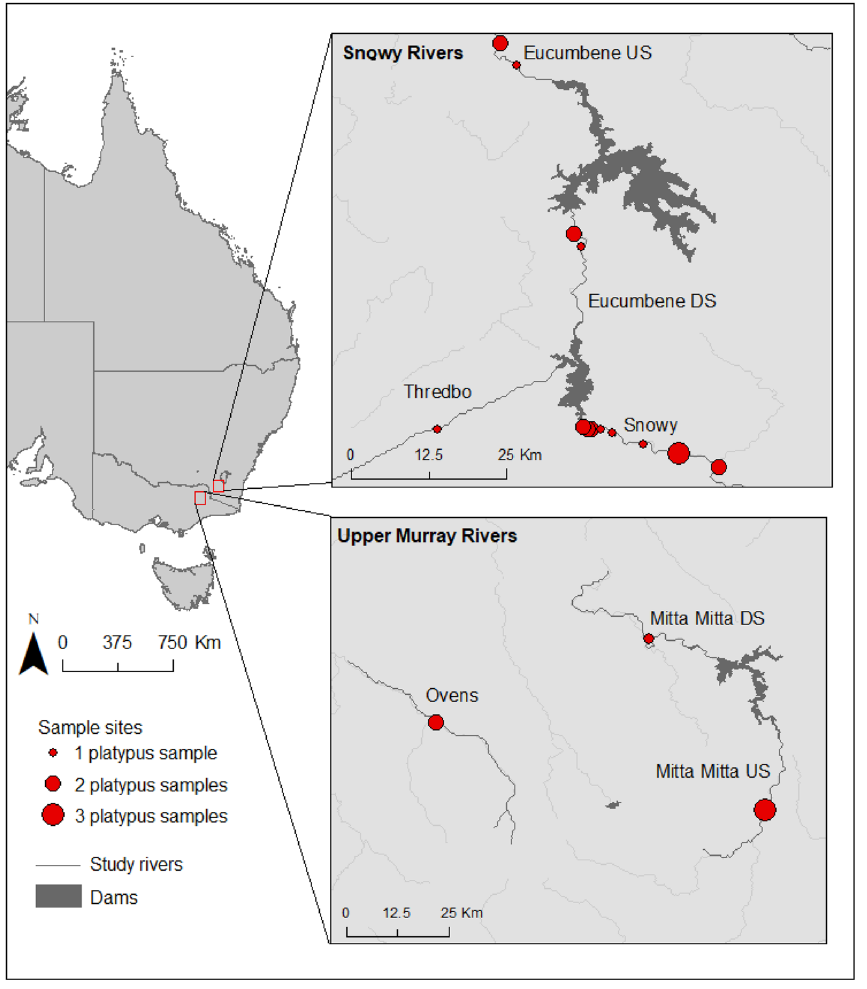
Figure 1. Sites along seven river sections (Snowy, Thredbo Eucumbene US and DS, Mitta Mitta US and DS, and Ovens) in the Snowy and Upper Murray Rivers where cheek pouch samples were collected from